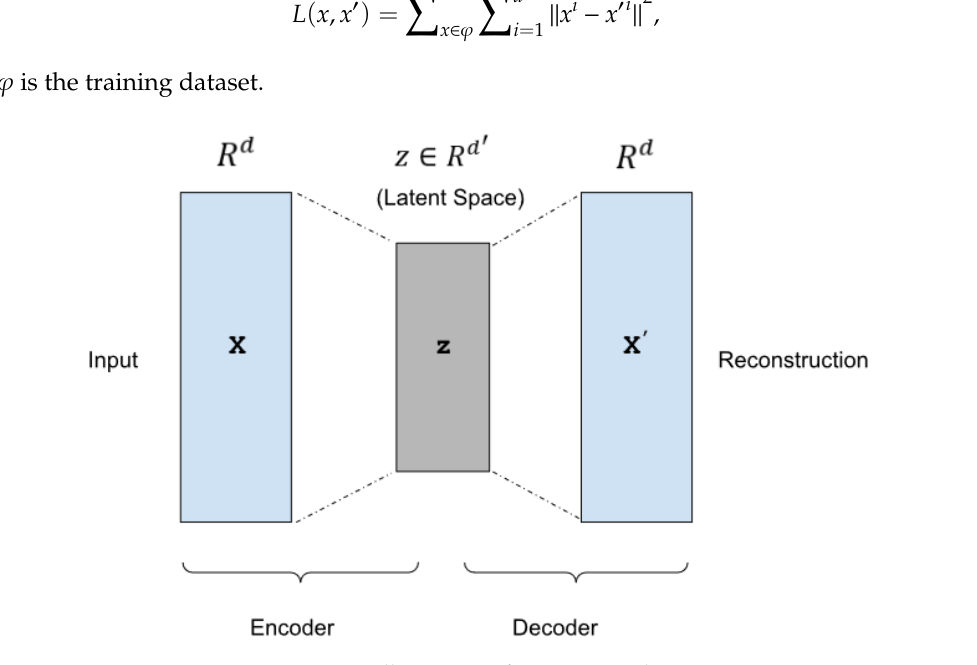
Figure 1. Illustration of an autoencoder.